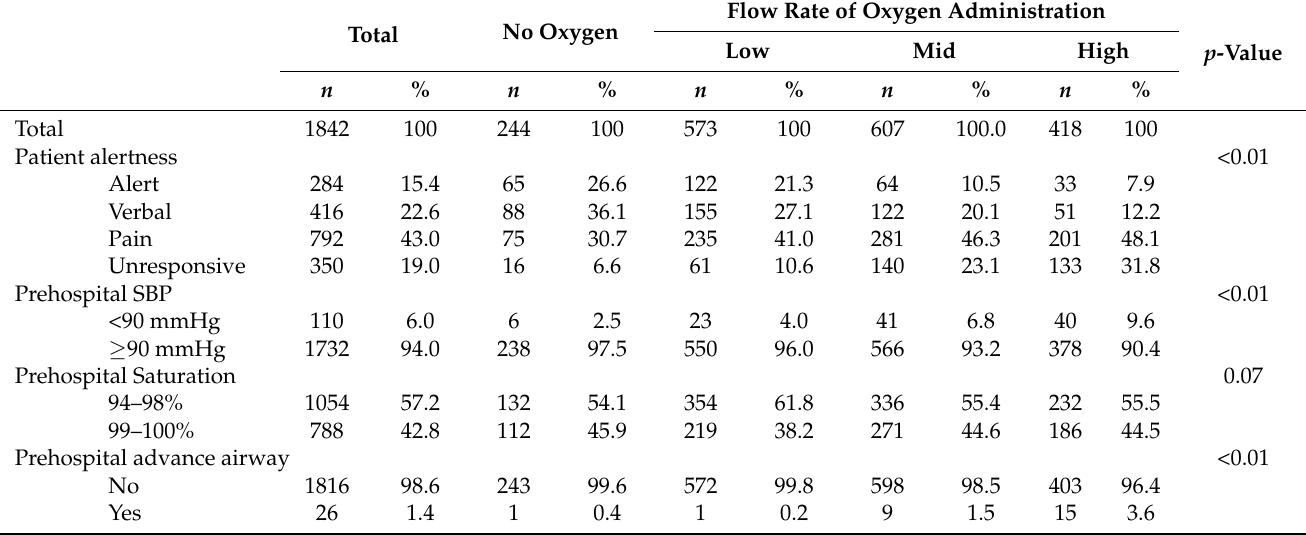
Table 2. Pre-hospital and in-hospital clinical findings according to flow rate of oxygen